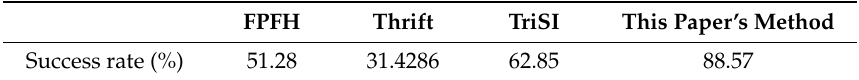
Table 2. The success rate of different registration